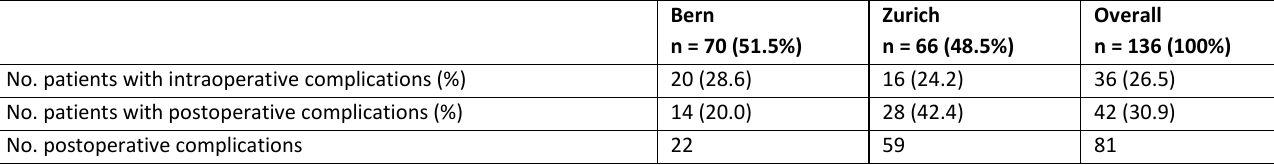
Supplementary table 7.1. Summary of perioperative complications of PC-RPLND.